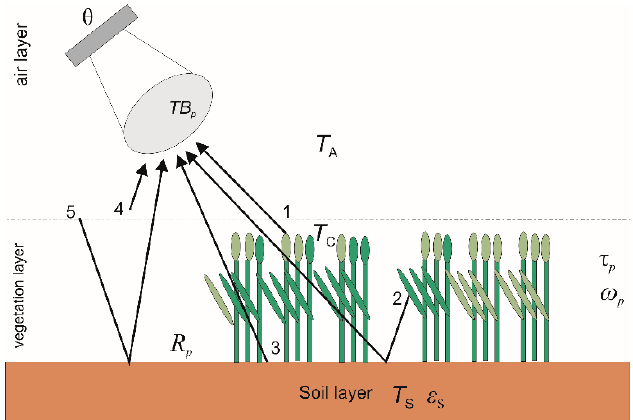
Figure 2. Schematic view of the τ - ω model used to describe the different contributions of the brightness temperature measured by a radiometer antenna at a specific incidence angle ( θ ). Here, a soil layer with a temperature T S is coved by a vegetation layer with a temperature T C and an air layer characterized by a temperature T A . The soil is also characterized by a soil surface reflectivity ( R p ) and a soil relative dielectric permittivity ( ε S ), while the vegetation is characterized by an effective scattering albedo ( ω p ) and a vegetation optical depth ( τ p ). Both vegetation parameters can be defined as polarization (indices p ) dependent (adapted from Mo et al. [12] and Vereecken et al. [4]). The brightness temperature ( T B p ) of a vegetated footprint can be described as: